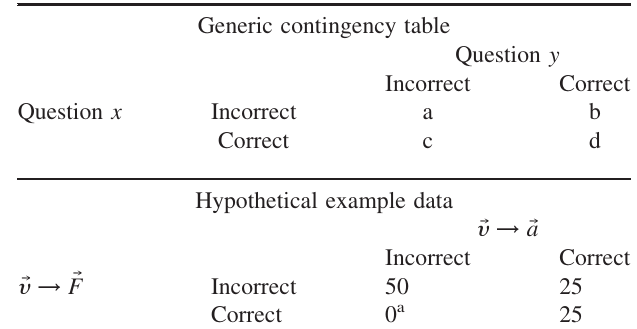
TABLE VIII. A simple method for ruling out or finding sup- porting evidence for possible hierarchical structure in answering. Consider the generic contingency table on the top. Here, for example, a is the number of students answering both x and y